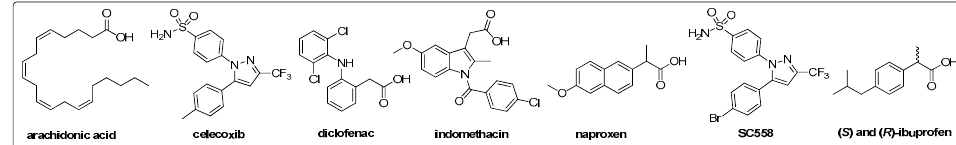
Table A3. Absorption, distribution, metabolism, and excretion–toxicity (ADMET) properties of best- docked compounds within the active site of COX-2.